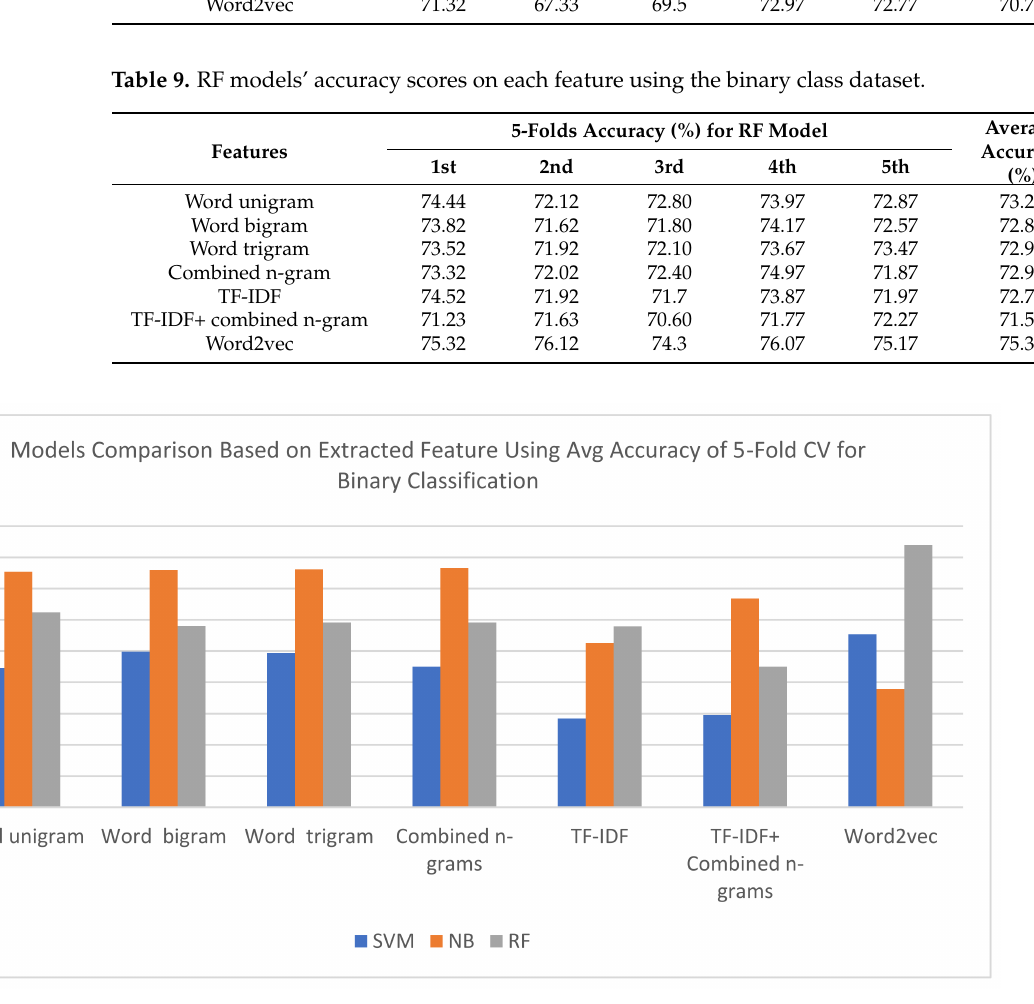
Figure 5. Binary models’ comparisons using CV average